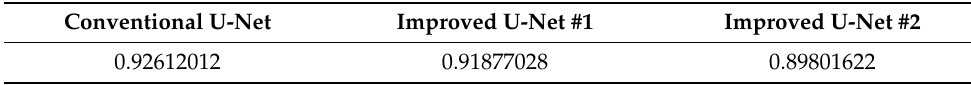
Table 10. AUC (small number of particles).